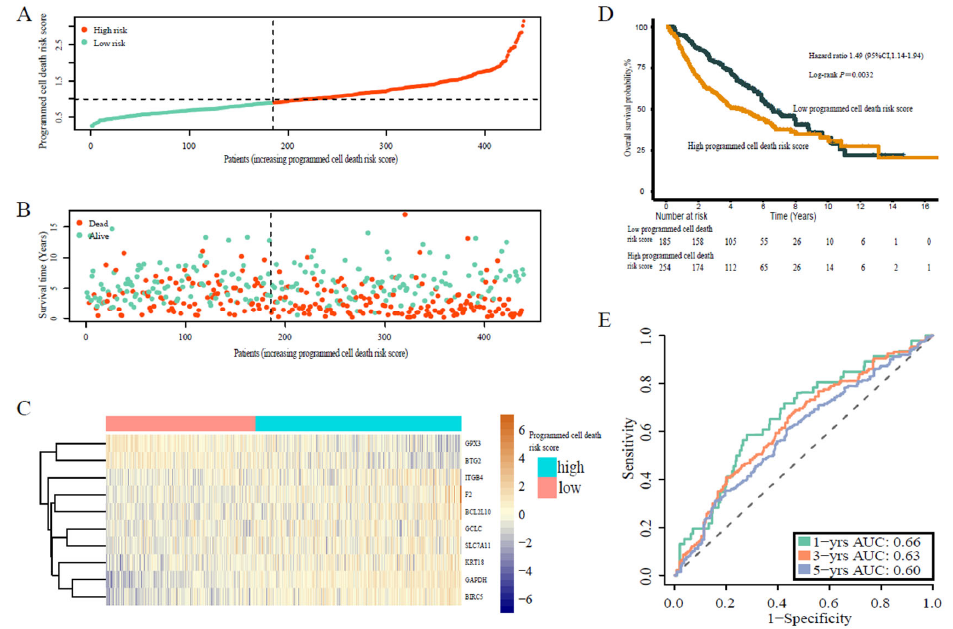
Figure 4. Prognostic analysis of programmed cell death risk score in validation cohort 2. ( A ) Distribution of programmed cell death risk scores in validation cohort 2. ( B ) Patterns of the survival time and survival status of the patients based on the programmed cell death risk scores. ( C ) Heatmaps of the ten prognostic genes for each patient of the training cohort. ( D ) Kaplan–Meier survival curve of the patients based on the programmed cell death risk scores. ( E ) Time-related ROC analysis showing the prognostic performance of the programmed cell death risk score formula in validation cohort 2.